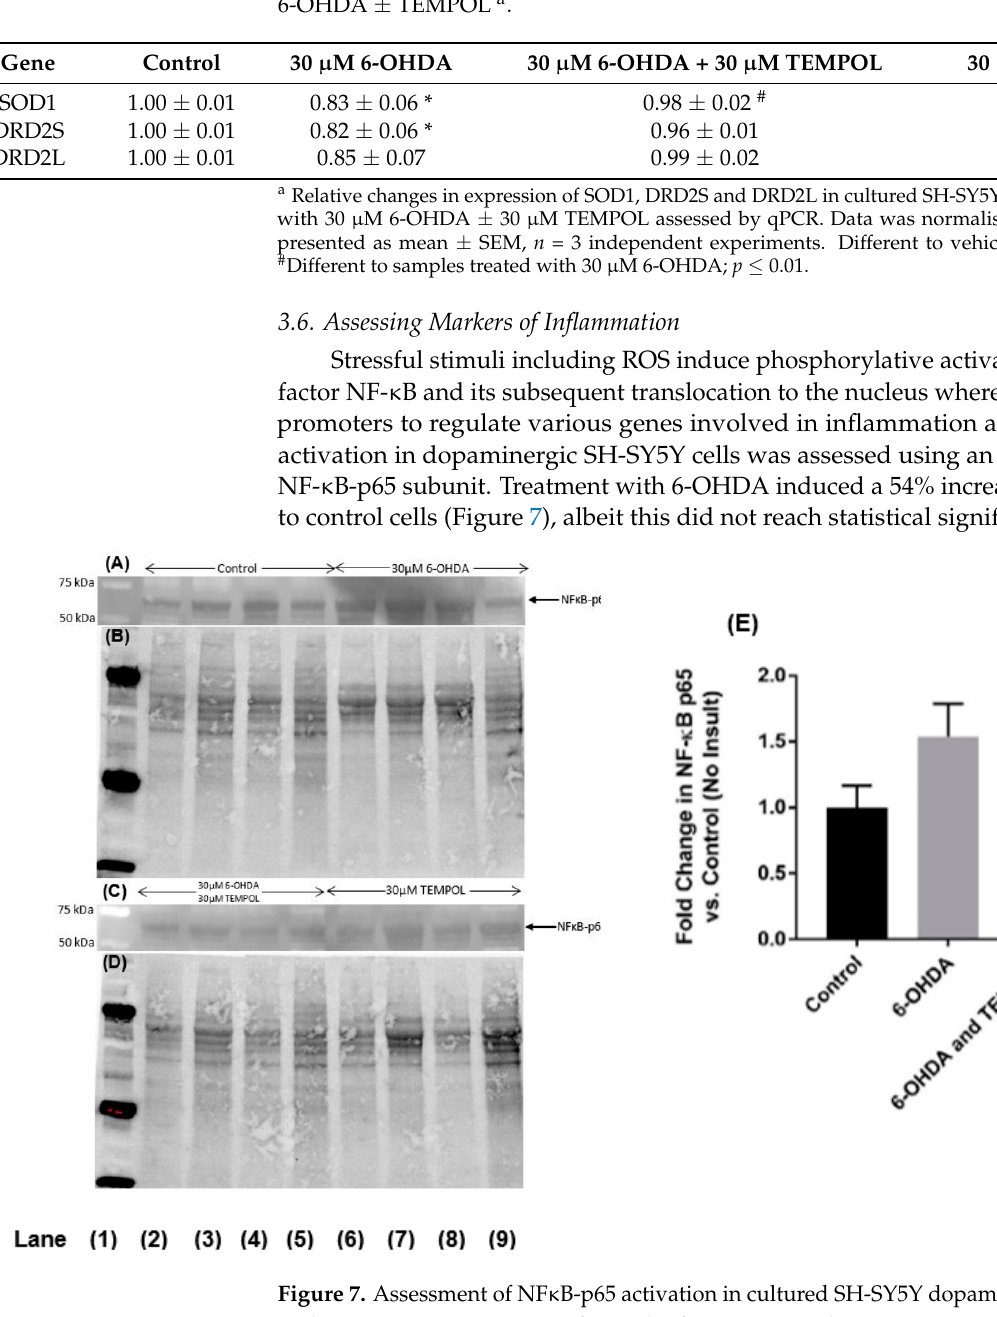
Figure 7. Assessment of NF κ B-p65 activation in cultured SH-SY5Y dopaminergic cells after treatment with 6-OHDA ± TEMPOL. After 24 h of treatment with 30 µ M 6-OHDA ± 30 µ M TEMPOL, cells were harvested, lysed, and the levels of NF κ B-p65 were determined by Western blotting: panel ( A ) representative blot Lane 1 molecular weight standard; Lanes 2–5 vehicle control; Lanes 6–9; cells + 6-OHDA and panel ( C ) representative blot Lane 1: molecular weight standard; Lanes 2–5; 30 µ M 6-OHDA + 30 µ M TEMPOL; Lane 6–9; cells + 30 µ M TEMPOL alone). Panel ( E ) corresponding densitometric analysis of protein bands with normalization to corresponding in gel total protein assessed in the same SDS-PAGE blot (in gel protein staining shown in panels ( B , D ) prior to transfer step). Data was expressed as mean ± SEM, n = 4 independent experiments; no significant differences were determined.